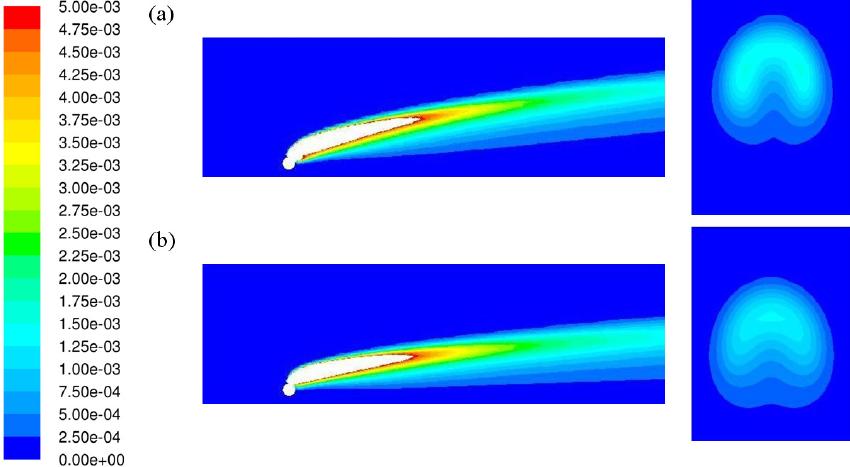
Fig. 4. Projections of 3-D pollutant concentration field: (a) constant velocity of the ambient flow : V = 0 . 15ms − 1 (b) logarithmic BBL profile V (y) = 0 . 144+0.033 ln(y)ms − 1 . Longitudinal view: vertical cross section passing through the port center (x=2.5m), and transversal view at a z-distance of 22m from the port. The unit of concentration is wt %.